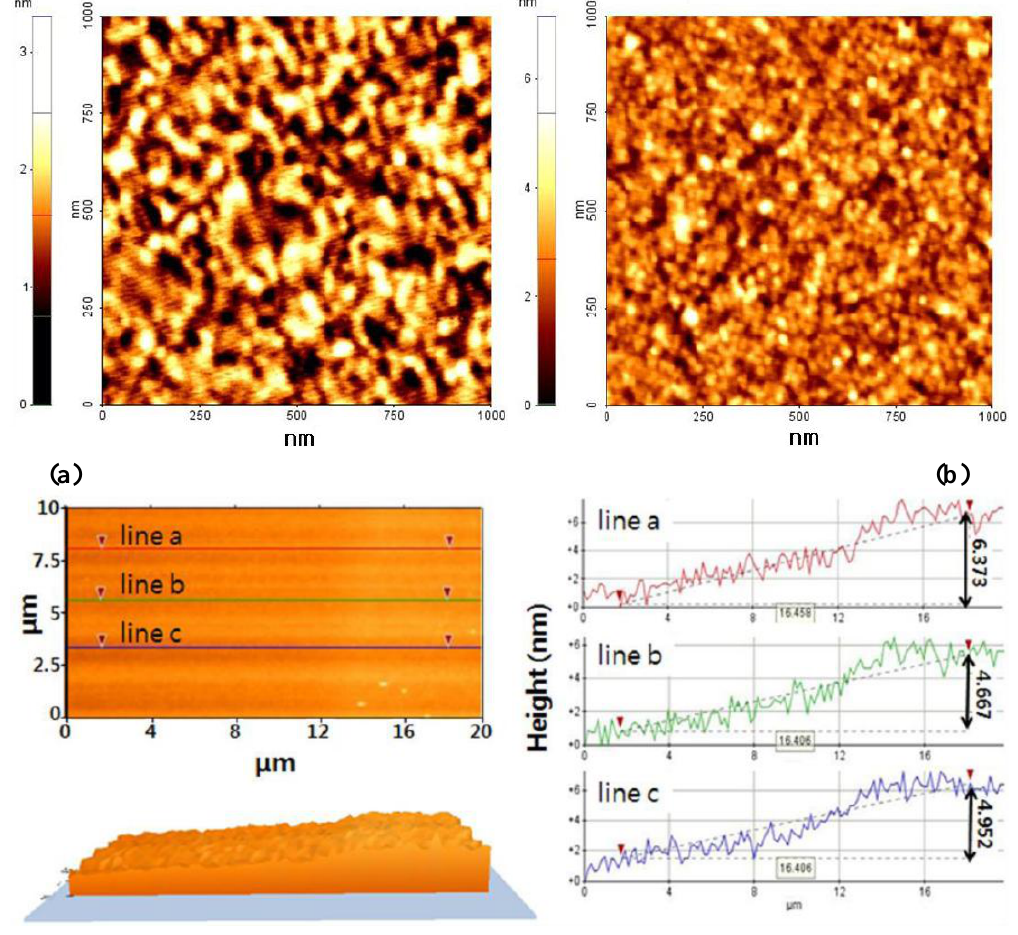
Figure 2. AFM images of surface morphology changes before (a) and after (b) the formation of the DON–MIPPy film. (a) is the surface image of the bare Au chip used for on the bare Au chip, and (c) is the image (2D, 3D and line profile) scanned on the border line between Au and MIPPy